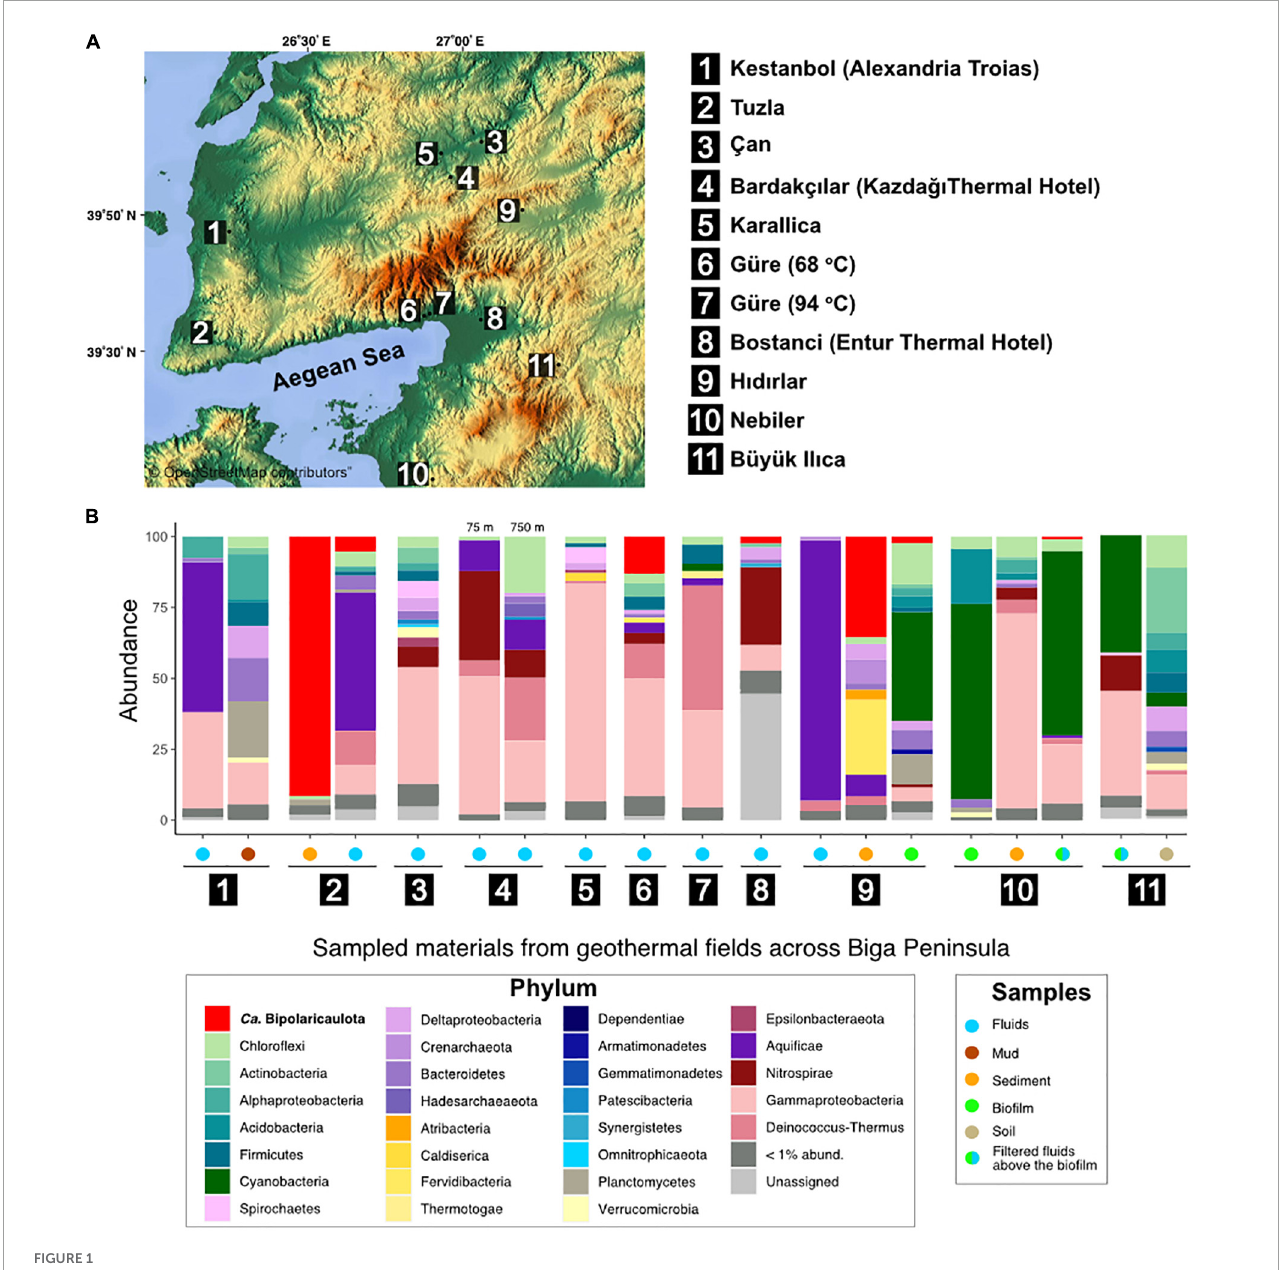
FIGURE1 Study sites and microbial community structure. (A) Map showing the location of the 11 geothermal sampling sites in Biga Peninsula, Turkey. The legend shows the names of the samples corresponding to the numbers on the map. (B) Microbial community structure of collected samples (filtered fluids, sediments, mud, and biofilm samples) from the studied geothermal represented as relative abundance of 16S rRNA gene sequences (y axis). These bars are only displayed for those samples where a phylum/class reached relative abundance in the 16S rRNA gene dataset > 1% in any of the samples. Legends show corresponding groups (left) and type of samples (right). The map used in this figure was created by Maps-For-Free which is credited in the image